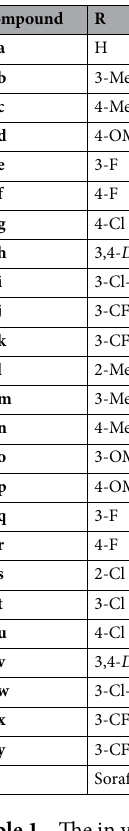
Table 1. The in vitro antiproliferative effects of the synthesized compounds. (IC 50 , µM) a values were determined by MTT assay. a Data are expressed as the mean ± standard deviation from the dose response curves of at least three independent experiments.